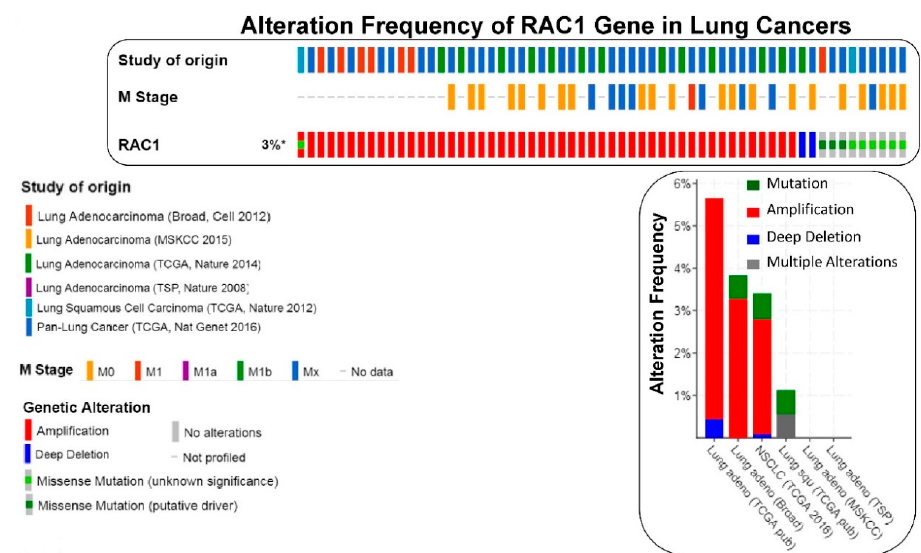
Figure 3. The frequency of alteration of the RAC1 gene in lung cancers: The oncoprint presents data obtained from c-BioPortal (February 2019) representing a combined study of 1933 samples (http://www.cbioportal.org), querying 1933 patients/samples in six studies as shown in the different color codes of the oncoprint (upper panel) under “Study of origin” in the figure. The percentage (3%*) represents the alteration of the RAC1 gene in patients with lung cancers. The lower panel of the oncoprint represents the types of alterations of RAC1 gene in samples as shown under “Genetic Alteration” in the figure. The middle panel of the oncoprint presents distribution of metastatic stage (M Stage as shown in the figure) of the patients where alteration of the RAC1 gene was identified. Unaltered cases (RAC1 gene) were not included in the oncoprint. The bar diagram (figure on the right panel) represents the frequency of alterations in the RAC1 gene in a few individual lung cancer studies where alteration was identified. The Y-axis of the bar diagram represents alteration frequency of the RAC1 gene (colors represent the type of alteration as shown in the figure). The frequencies of alterations are sorted on the X-axis according to “Cancer Study”.